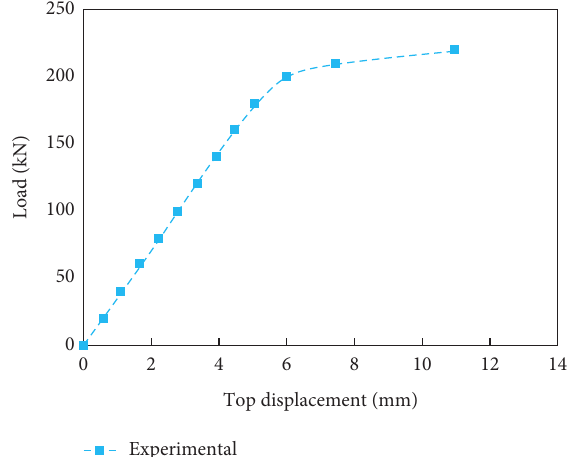
Figure 18: Frame push curve resulting from experiment [29].